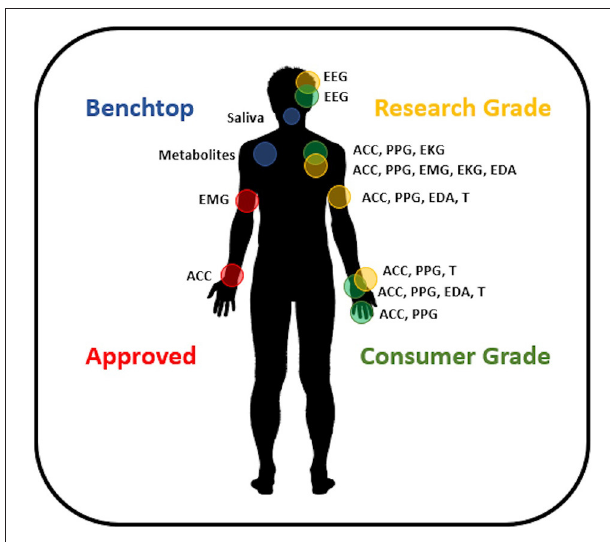
FIGURE 1 | Available wearable devices for seizure management. Approved devices include sensor systems CE Marked and/or FDA approved for epilepsy. Research grade devices are commercially available and provide accurate, high-quality data. Consumer grade devices are commercially available sensors designed around applications where data accuracy is not crucial and may utilize interpolation or estimation methods to provide information to the user. Benchtop devices are innovative sensors under development and not available commercially. EEG, electroencephalography; ACC, accelerometry; PPG, photoplethysmography; EKG, electrocardiography; EMG, electromyography; EDA, electrodermal activity; T,